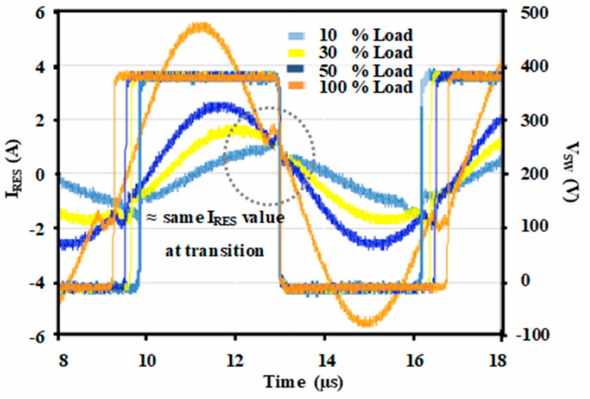
Figure 8. Experimental I RES and V SW measured at di ff erent loads for DUT1 as an example of how the resonant current varies with the load. As can be seen, di ff erent switching frequencies are also used for di ff erent